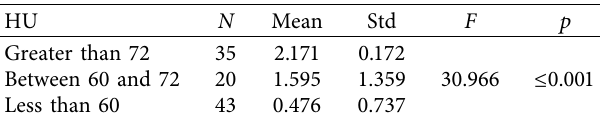
Table 3: Results of analysis of variance for the ovomucin con- centration at various HU